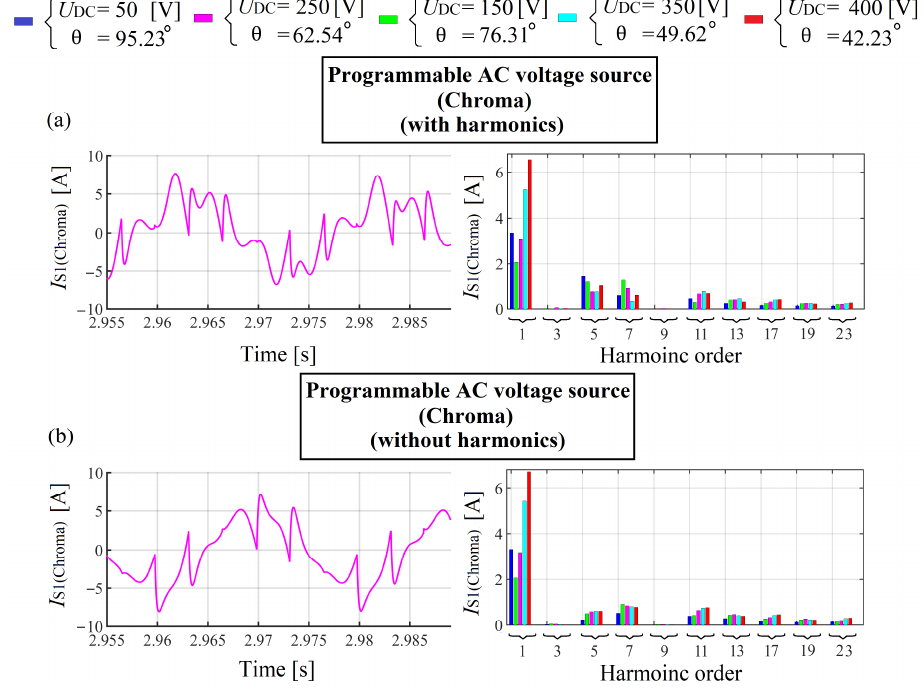
Figure 33. Current waveforms and spectrums measured at the input of the Chroma voltage source with ( a ) harmonics and ( b ) without harmonics. The line reactor L SS is considered.